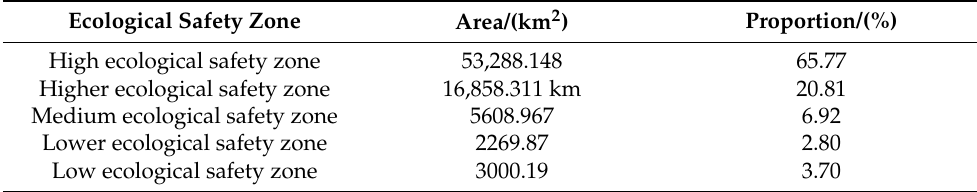
Figure 4. Single-factor resistance surface. Table 7. Area statistics of Ecological Safety Zone